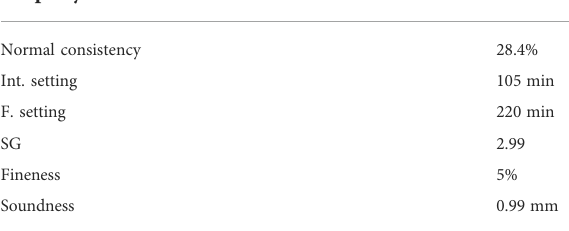
TABLE 1 Physical properties of cement.